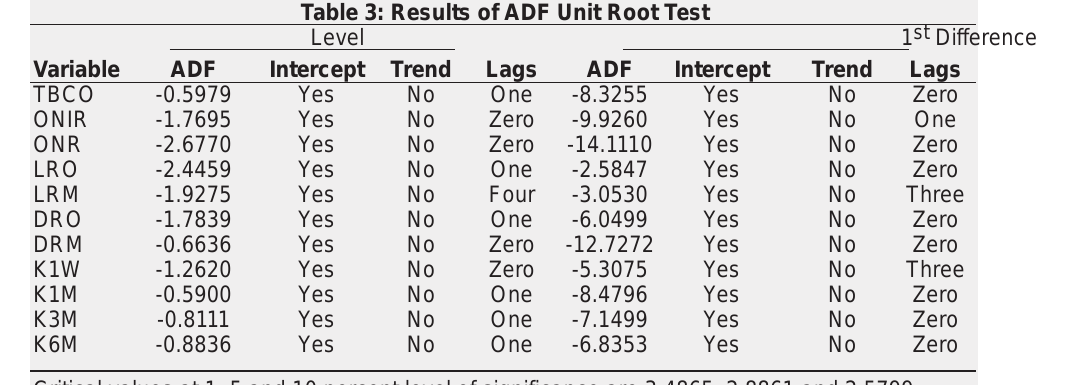
Table 3: Results of ADF Unit Root Test Level 1 st Difference